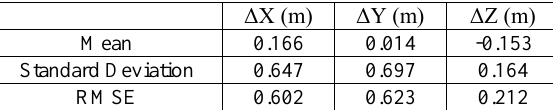
Table 2. Errors estimated from 4 corner points of a rooftop.